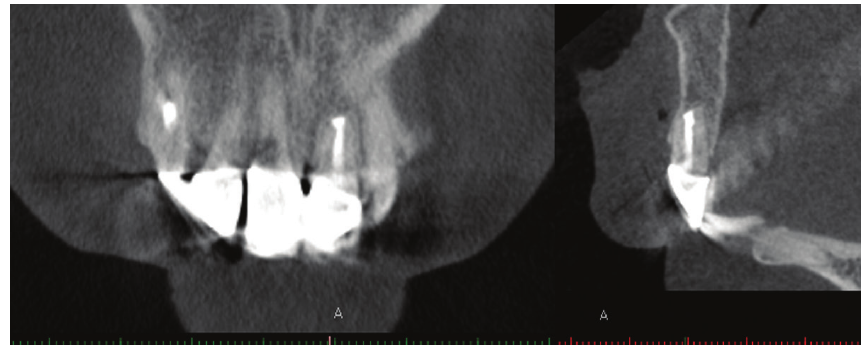
Fig. 3. A 24-month follow-up CBCT scan showed the healed periapical lesion and no sign of root